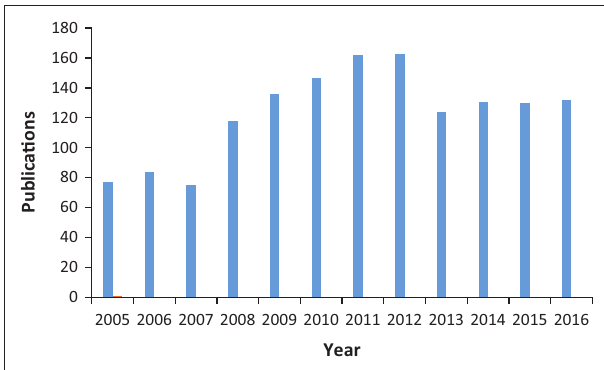
FIGURE 1: Number of publications on organisational culture for each year from 2005 to 2016 in the Web of Science.